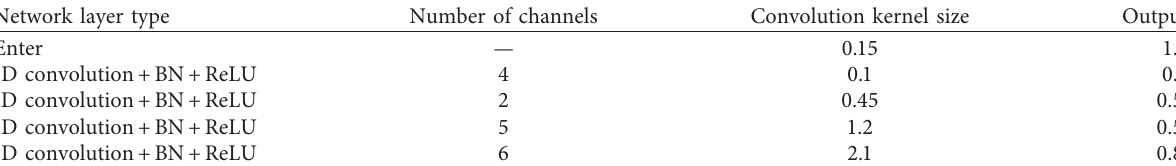
Table 1: Motion position and size history encoder network architecture configuration